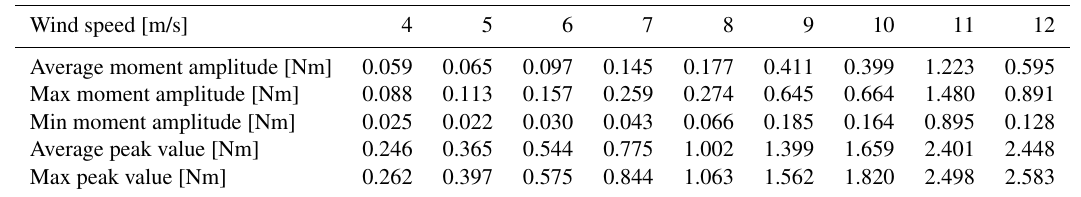
Table 3. Case B testing parameters of bending moments for wind speed range.